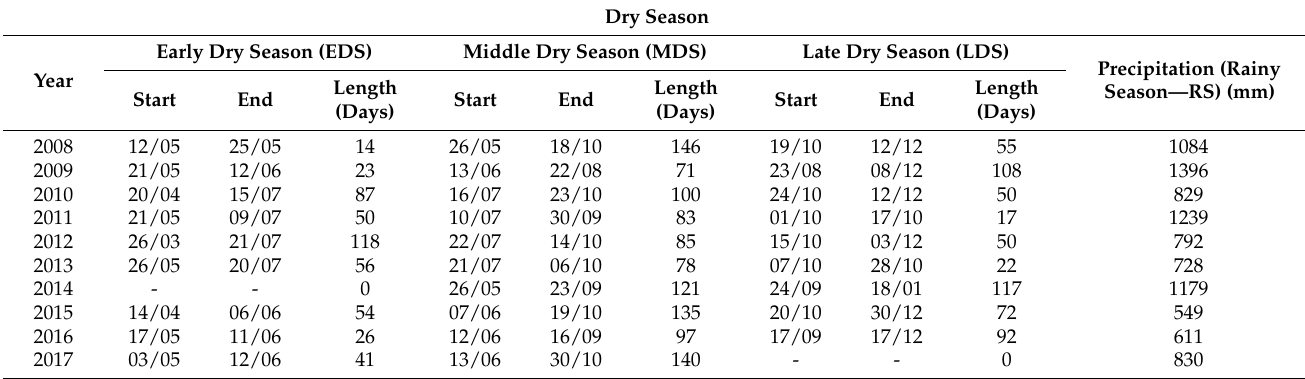
Table 3. Dates of beginning and end, and length of each dry season between July 2008 and June 2017. The precipitation accumulated in the rainy season is also shown.